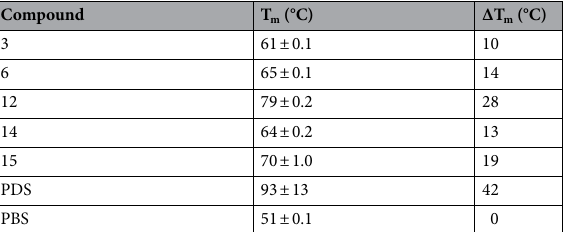
Compound T m (°C) ΔT m